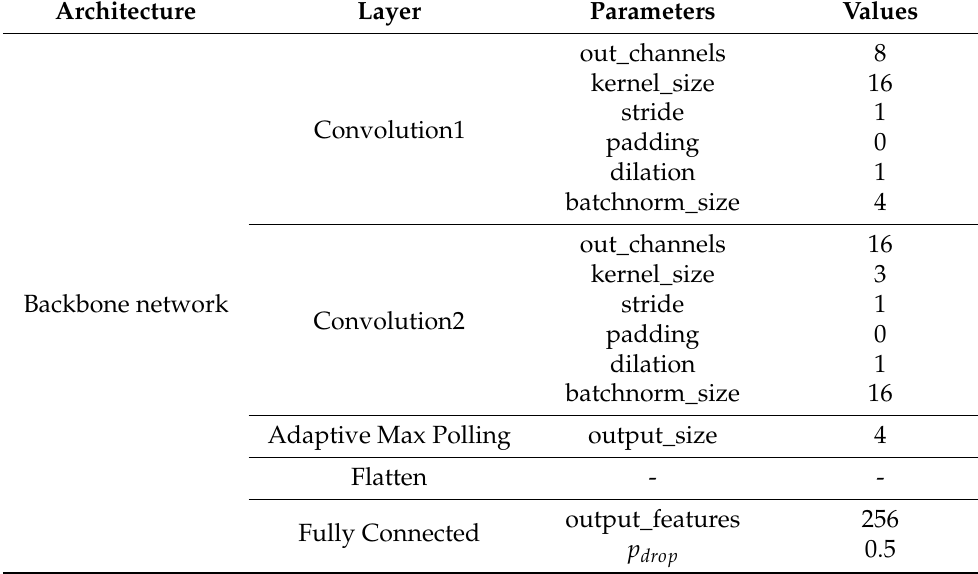
Table 4. Backbone Parameters of